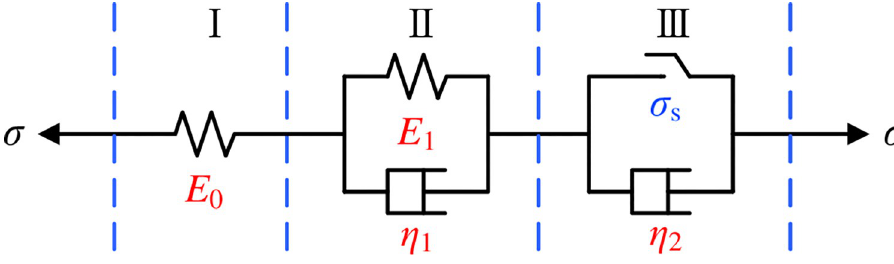
Fig 1. The classic Nishihara